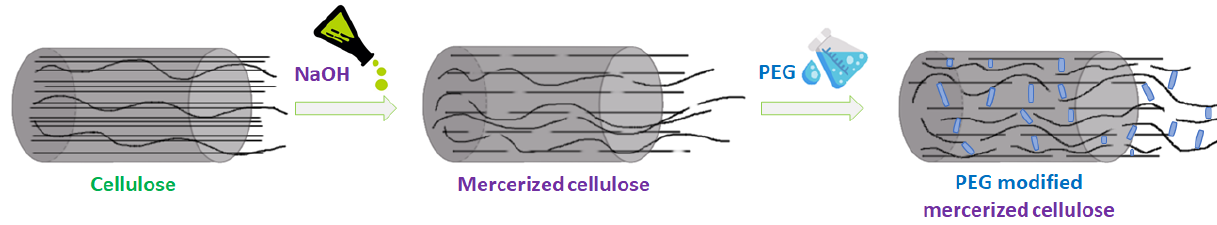
Figure 5. Scheme of modification of cellulose particles.